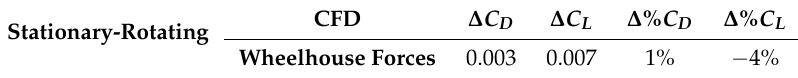
Table 4. Computational wheelhouse forces: